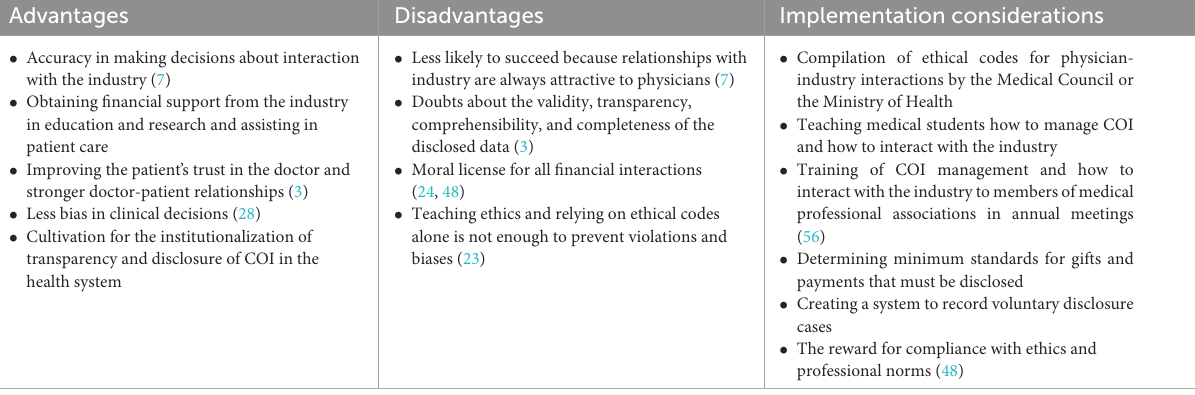
TABLE 6 Advantages, disadvantages, and implementation considerations of policy options: 4. Voluntary industry disclosure.